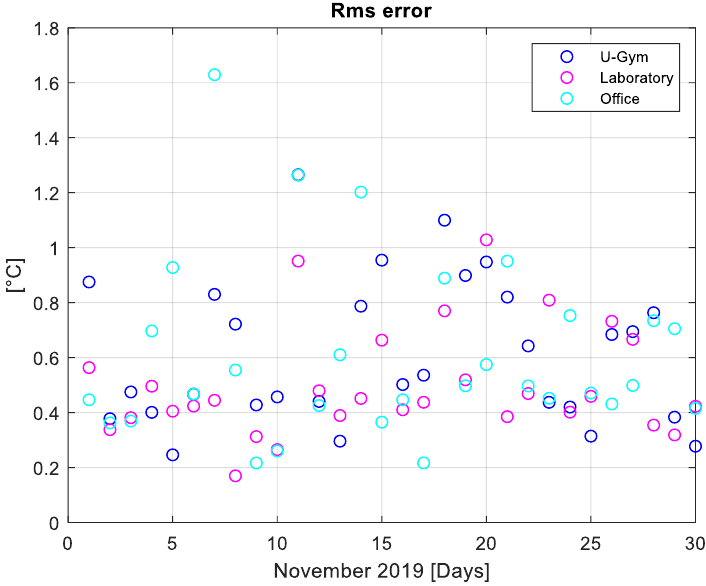
Figure 13. Daytime temperature root mean square error.